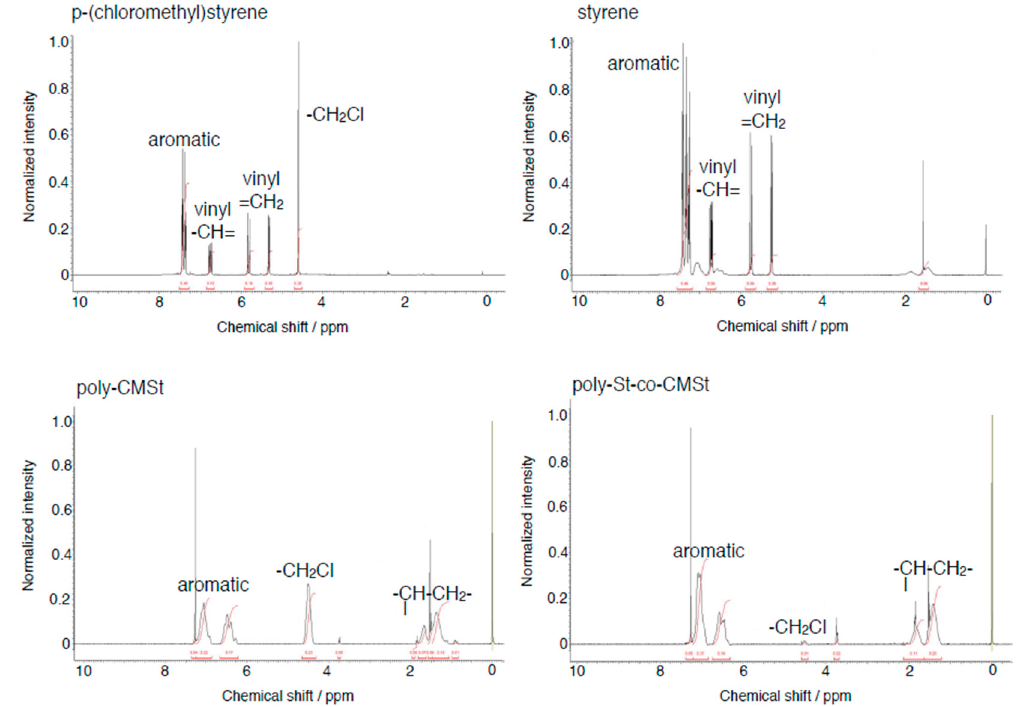
Figure 8. 1 H nuclear magnetic resonance spectra observed for monomers (p-(chloromethyl styrene and